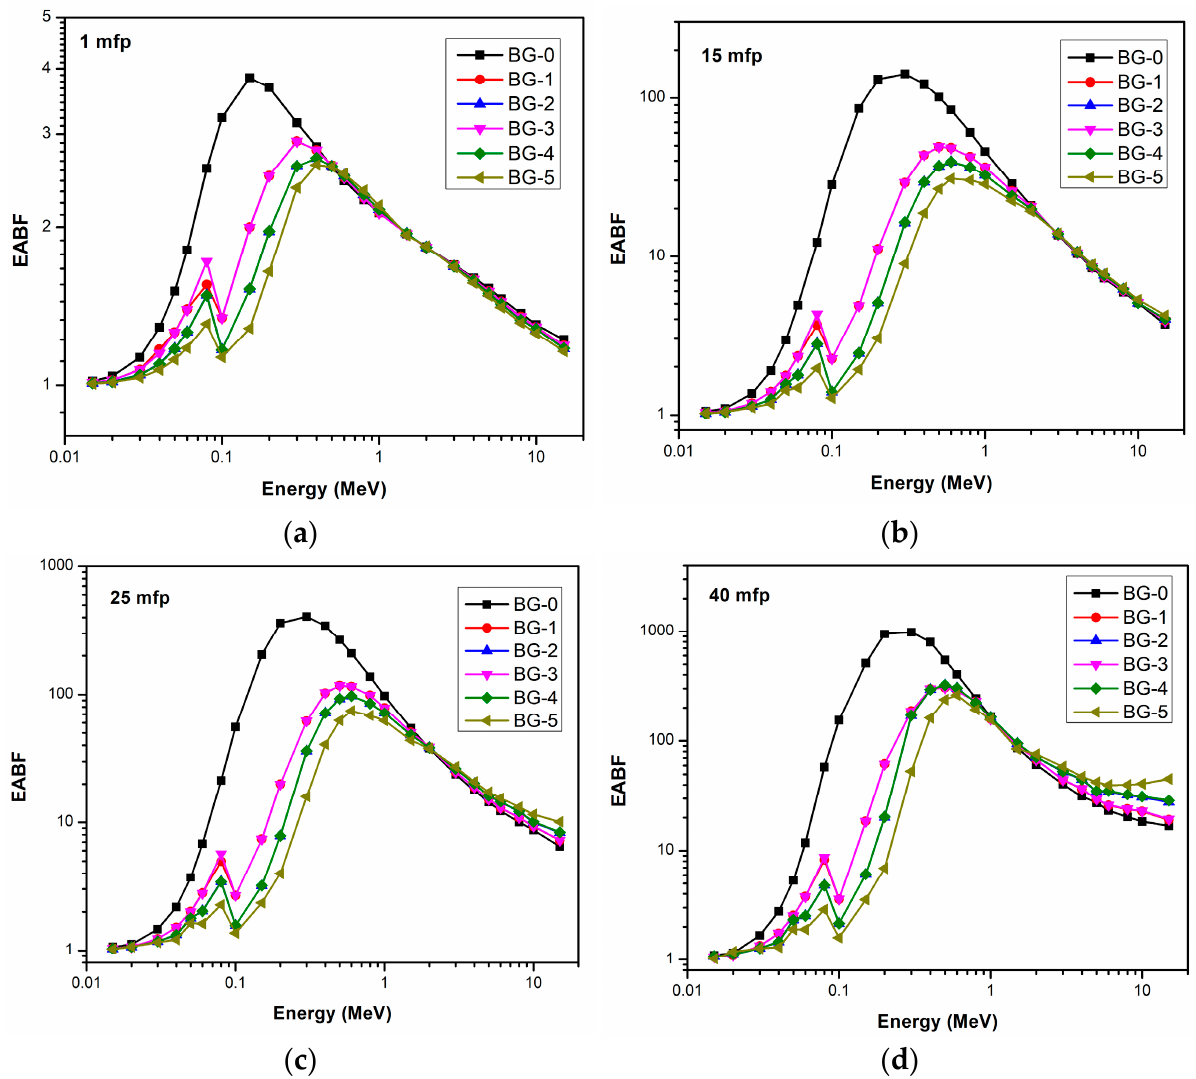
Figure 7. EABF as a function of photon energy at ( a ) 1mfp, ( b )15 mfp, ( c ) 25 mfp, and ( d ) 40 mfp for bismuth oxide bentonite–gypsum.